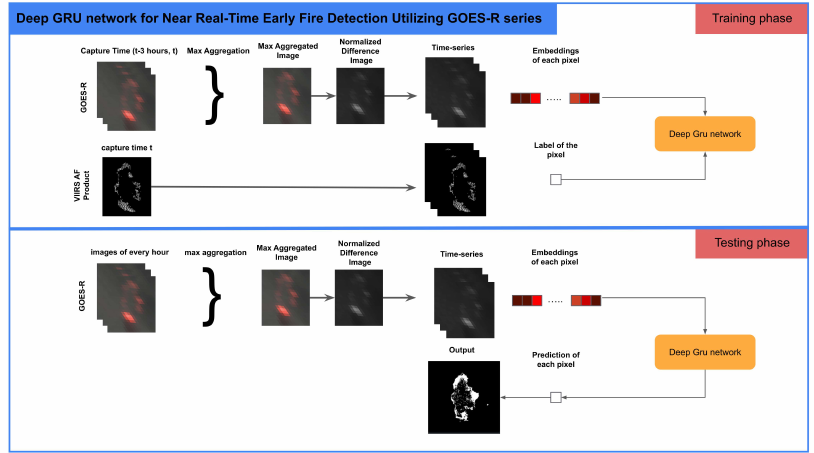
Figure 3. Deep GRU Network for Early Fire